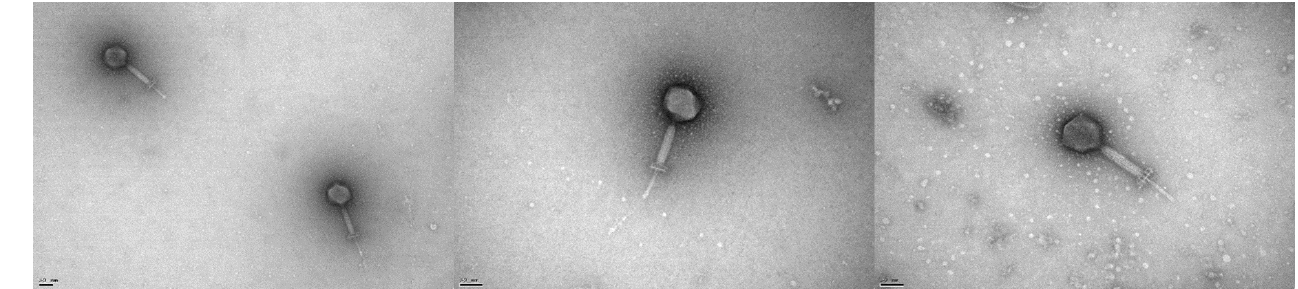
Figure 1. Electron photomicrographs of phage vB_EfmH_163. The scale bar represents 50 nm. To better characterise the phage cycle, a one-step growth curve was constructed. The latent period was estimated to last around 60 min; the burst size was about 155 PFU